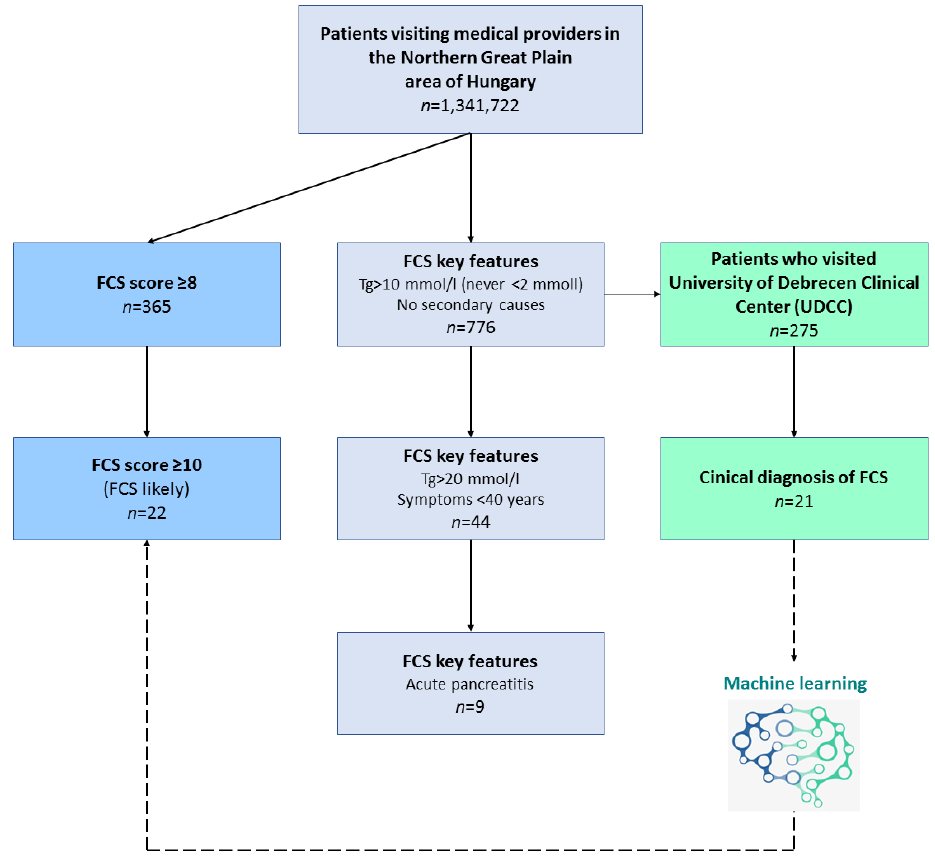
Figure 1. Flowchart of the rapid estimation of familial chylomicronemia (FCS) score.